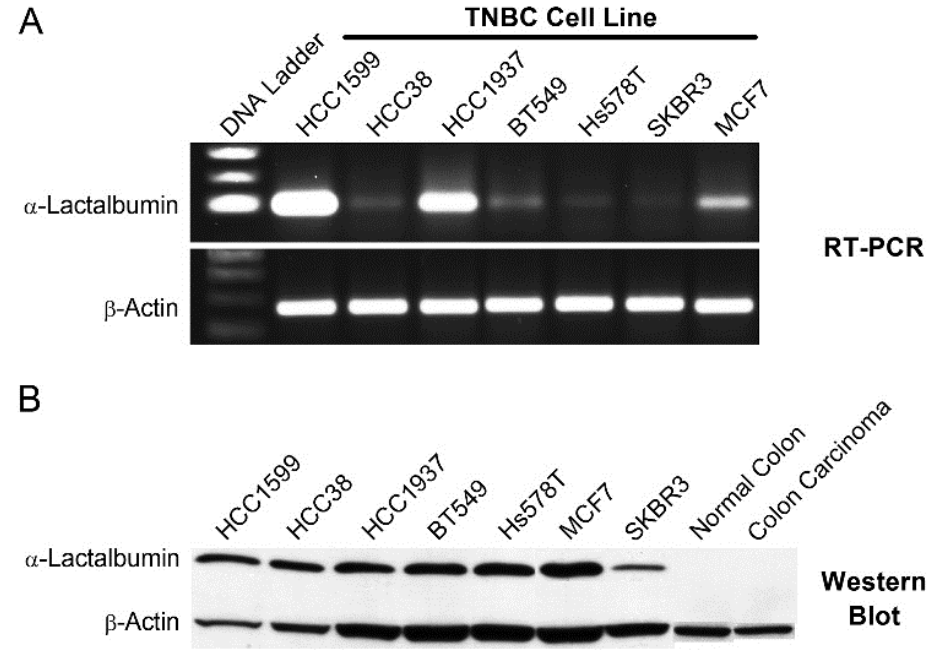
Figure 3. α-Lactalbumin Gene Expression and Protein Detection in Human Triple Negative Breast